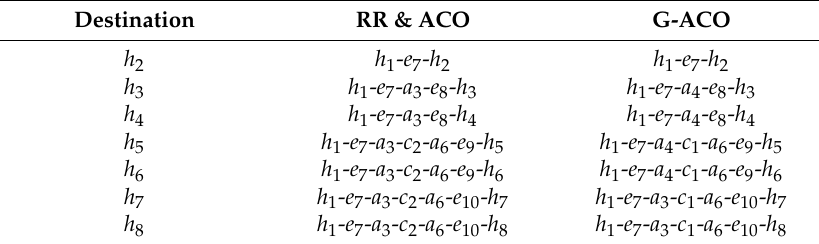
Table 6. The selected path with the three schemes.